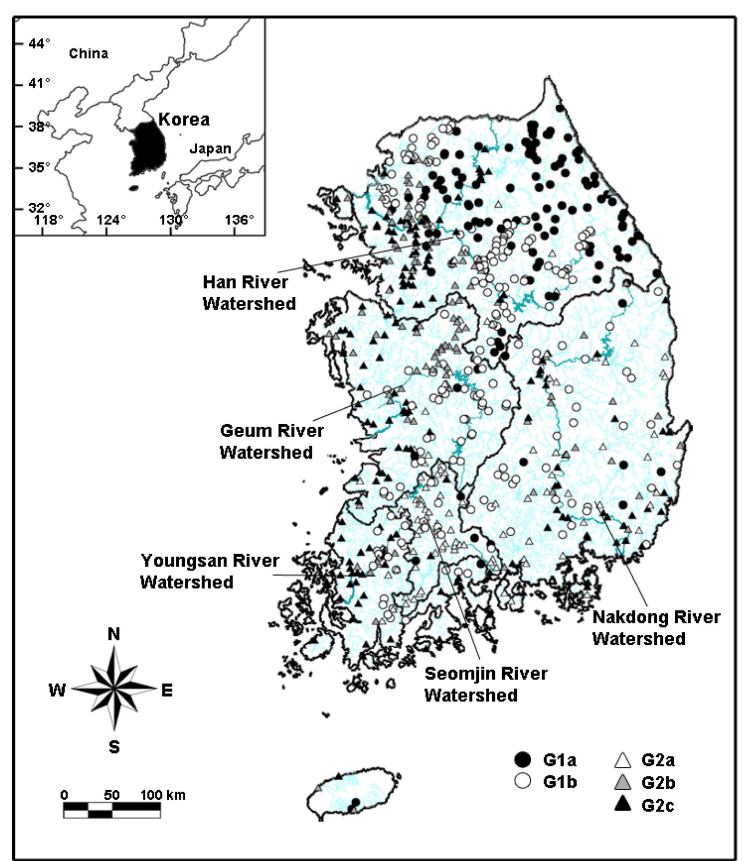
Figure 1. Geographic locations of the study sites. Five macroinvertebrate-based site groups were classified as G1a ( n = 126, black circles), G1b ( n = 199, white circles), G2a ( n = 106, white triangles), G2b ( n = 118, gray triangles), and G2c ( n = 171, black triangles) based on Sørenson distance measure cluster analysis. Dark lines indicate the five large rivers and the light lines display their tributaries and small independent